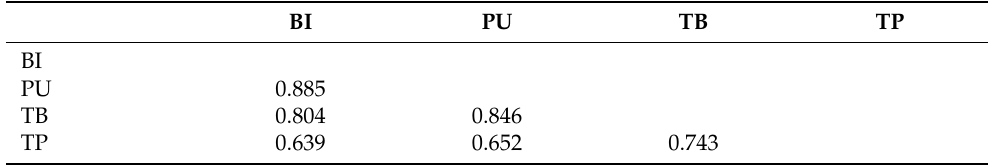
Table 5. Discriminant Validity using